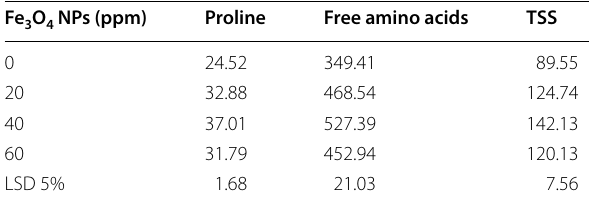
Table 6 Effect of foliar application with Fe free amino acids and total soluble sugars (mg/100 g dry wt) of Moringa oleifera